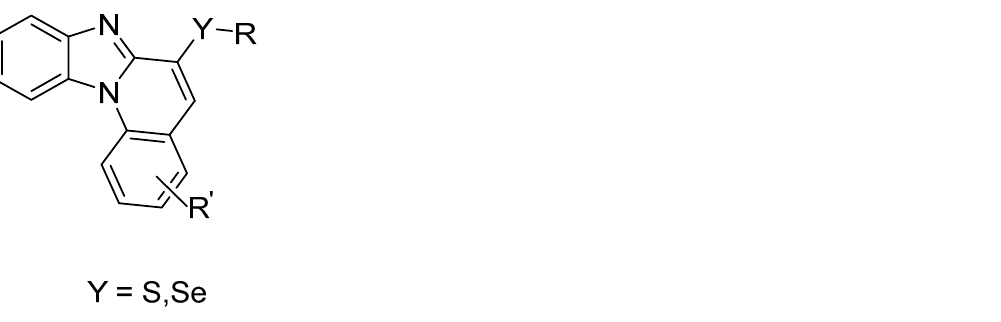
Figure 6. Molecular structures of the novel benzimidazo[1,2–a]quinoline derivatives reported by Da Silva et al.